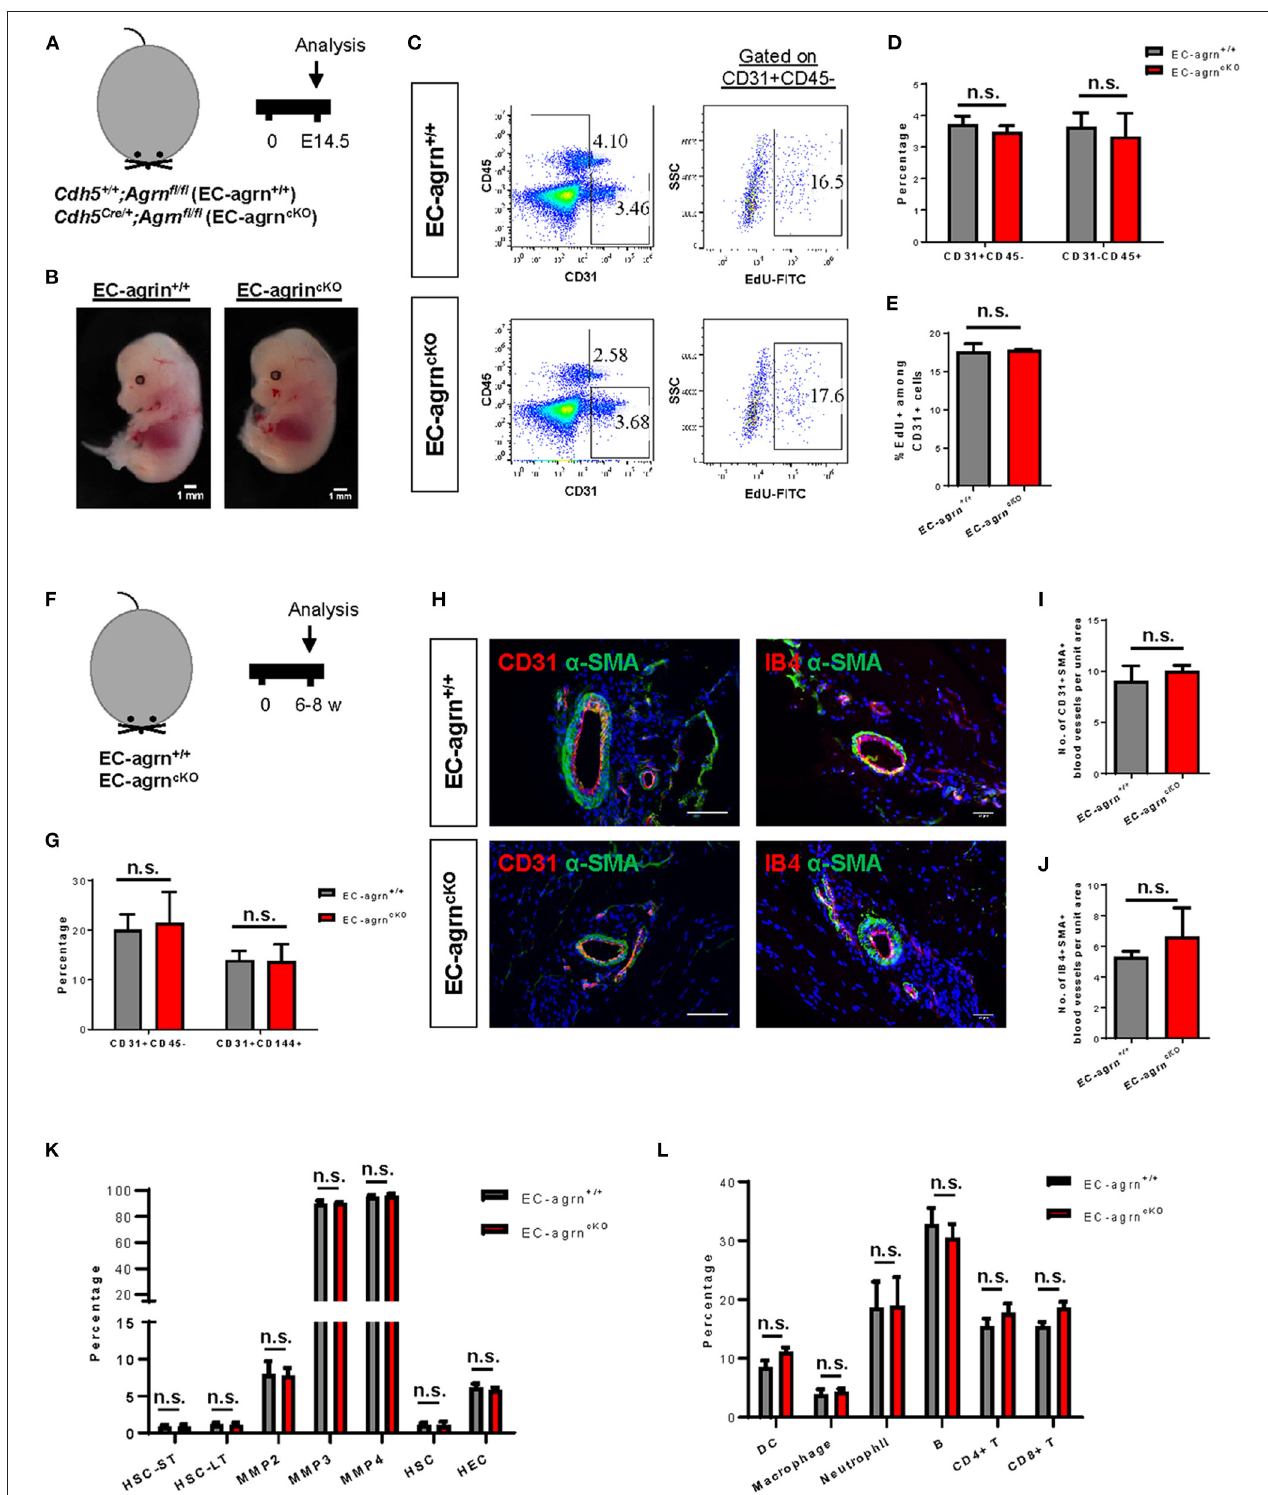
FIGURE 1 | Endothelial agrin is dispensable for endothelial and haematopoietic cell development. (A) Schematic diagram showing the experimental design in embryos of Cdh5 Cre / + ;Agrn fl / fl (EC-agrn cKO ) and Cdh5 + / + ;Agrn fl / fl (control, EC-agrn + / + ) mice. (B) Embryos harvested at embryonic day (E) 14.5 showing no